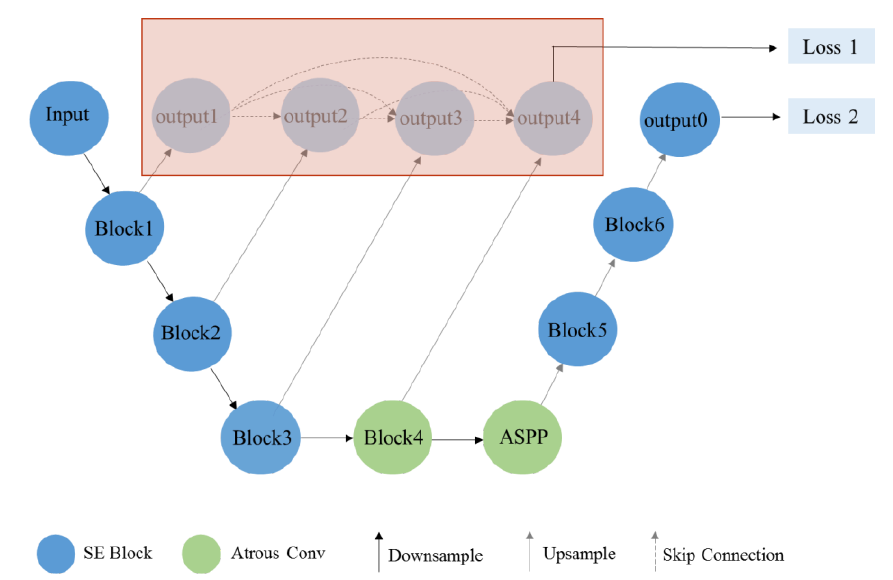
Figure 6. The structure of the encoder and decoder of Nested SE-Deeplab during training and testing. The structure of red region is needed during training, and the red region can be hidden during testing.